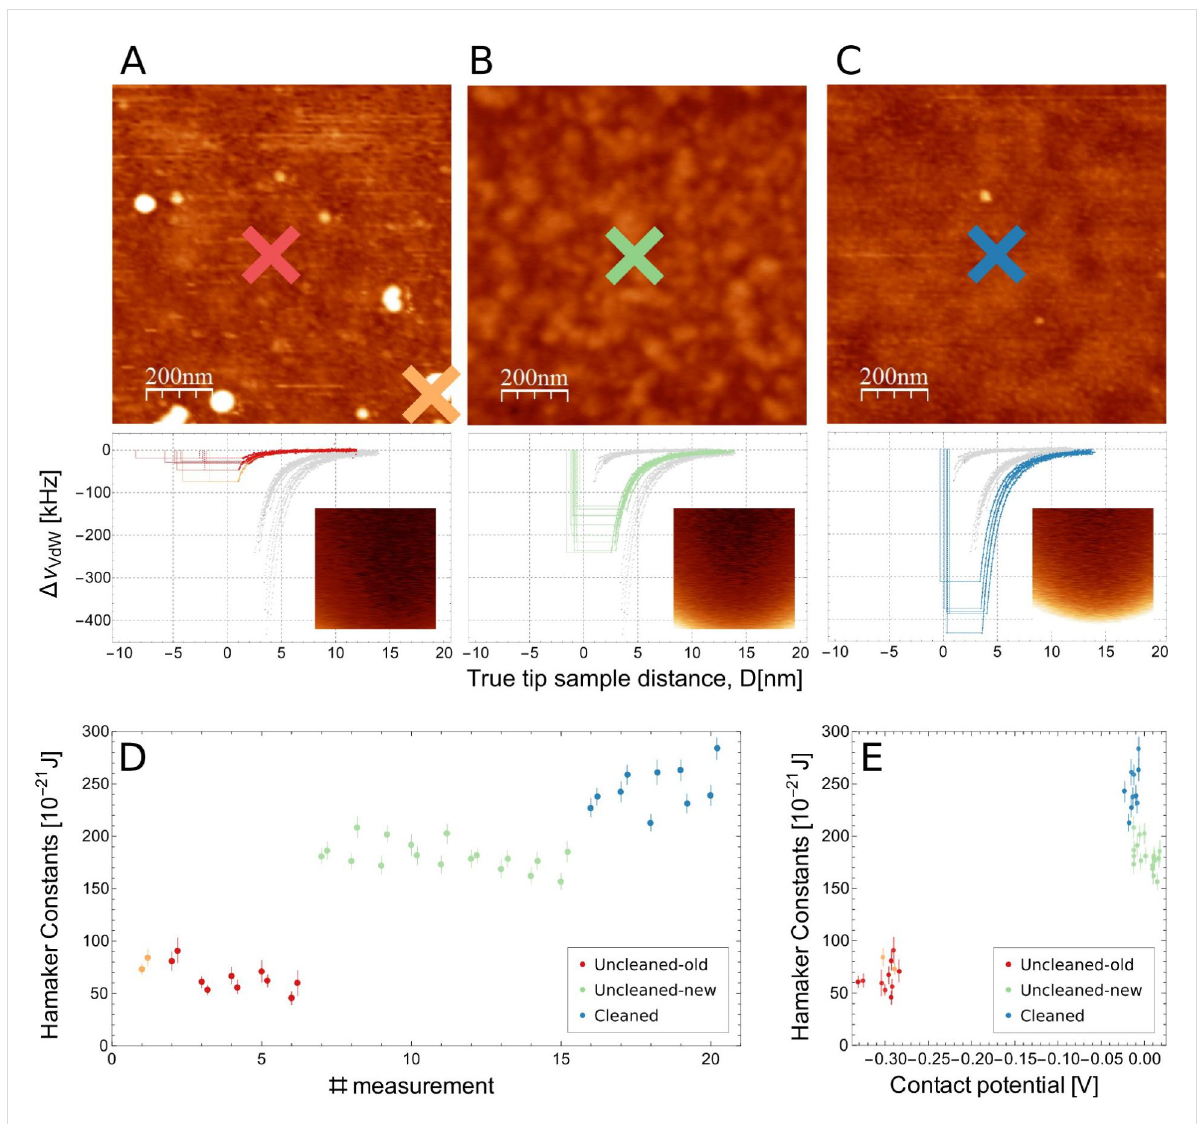
Figure 3: Topography images and spectroscopy data at specific locations on three different Pt-coated cantilever chips used as samples. Each chip has a different degree of contamination: “uncleaned–old” (column A), “uncleaned–new” (column B) and “cleaned” (column C). Top row: topography images. Middle row: van der Waals spectroscopy curves Δν vdW ( d ). The different curves are shown in the color corresponding to the cross in the topo- graphic images above marking the position of the spectroscopy experiment. Note that in each graph all curves are shown; those at the position marked in the topographic image above are shown in colour, while all the other curves are shown in grey for comparison. The tip–sample distance corresponds to the true tip–sample distance, i.e., d = 0 corresponds to the positon of the surface as seen by the van der Waals interaction. The vertical lines to the left (negative distance) of the experimental Δν vdW ( d ) curves in these graphs show the electrostatic pole (see main text). The inset in these graphs show one of the interaction images (raw data, total color scale 300 Hz, the horizontal scale (fast scan, bias voltage) corresponds to ±0.8 V and the vertical scale (slow scan, tip–sample distance) corresponds to 10 nm. The Δν vdW ( d ) curves are calculated from these interaction images. Bottom row: Hamaker constant (D) and Hamaker constant versus contact potential diagram (E) for all spectroscopy experiments acquired at the positions shown in the different topographic images. The colors of the data points correspond with the positions of the different data sets (and samples) marked in the topographic